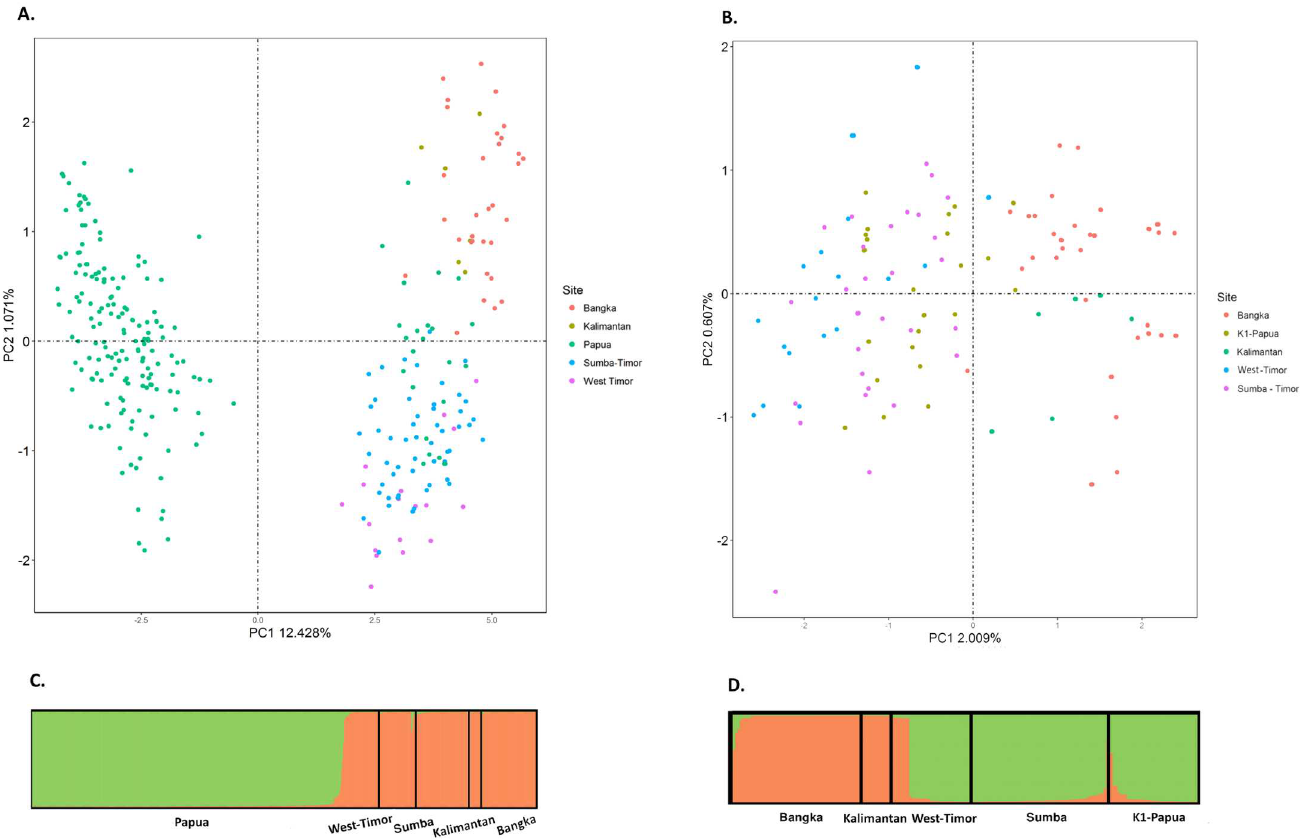
Fig 2. Principal coordinate analysis (PCoA) and STRUCTURE plots illustrating the genetic differentiation between P . falciparum isolates from Timika relative to Kalimantan, Bangka, Sumba and West Timor. Panels A) and B) present PCoA and STRUCTURE bar plots, respectively, illustrating the similarity betweenthe Timika K1 subpopulation and the other four islands. The STRUCTURE bar plot presents the results for K = 2. PanelsC) and D) present PCoA and STRUCTURE bar plots, respectively, for all five P . falciparum populations, with the exclusionof the Timika K2 subpopulation, illustrating the greater relatednessbetweenK1 and Sumba relative to the other islands. The STRUCTURE bar plot presents the results for K = 2, separatingK1, Sumba and West Timor in the east from Kalimantanand Bangkain the west.